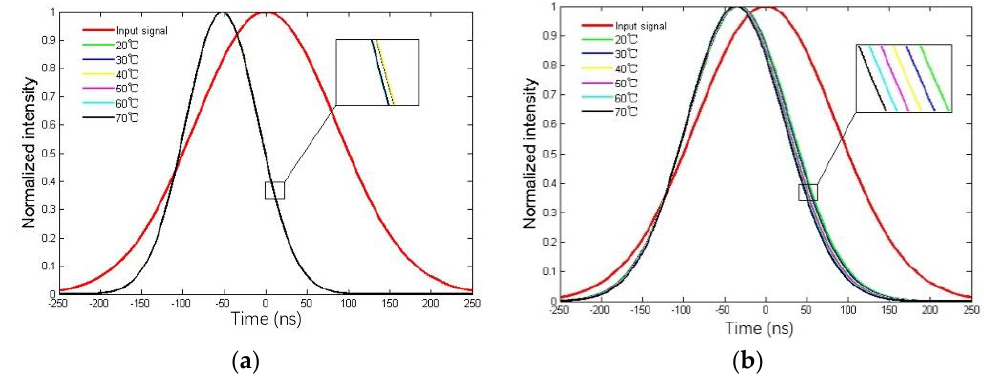
Figure 9. The output waveform of pulse signal for different temperature in ( a ) ethanol-unfilled and ( b ) ethanol-filled PCF.